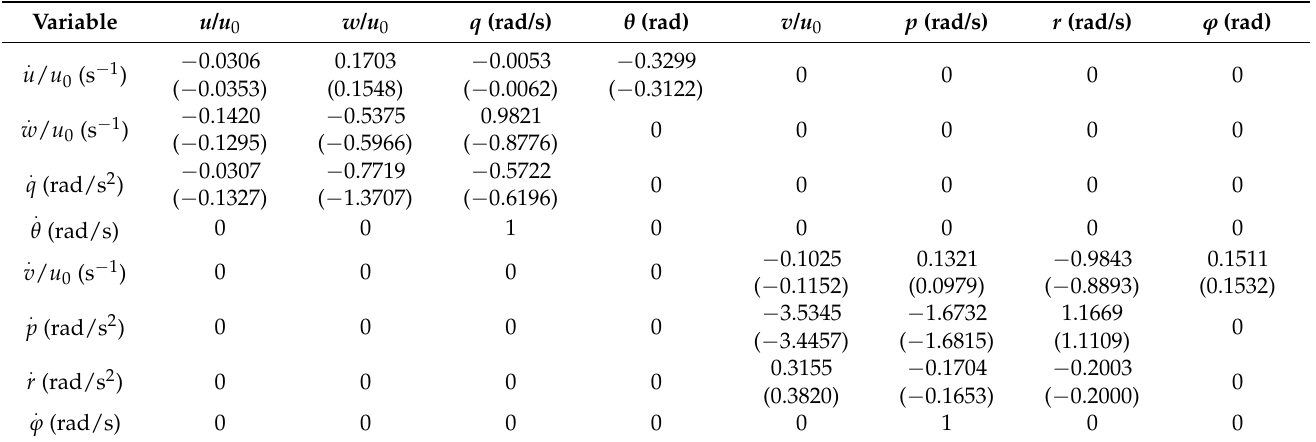
Table 23. CFD–RANS (extrapolated) 8 × 8 stability matrix for flight condition 17 in Tables 4 and 22 (reference takeoff case).